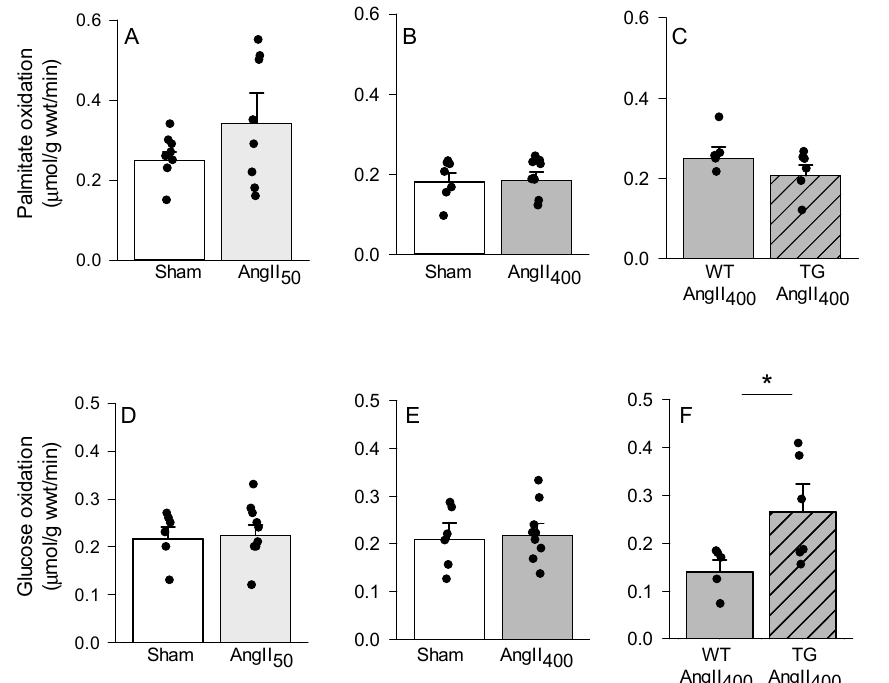
Figure 2. Palmitate ( A–C ) and glucose ( D–F ) oxidation rates assessed in isolated working hearts from C57BL/6J, wild-type (WT), and csNOX2 transgenic (TG) mice treated for two weeks with micro-osmotic pumps containing either saline (sham), 50 or 400 ng/kg/min angiotensin II (AngII 50 and AngII 400 ). The data are presented as mean ± SEM. * p < 0.05 vs. WT. The oxygen consumption rate (OCR) through the complexes in the electron transport system in the mitochondria was measured in homogenates from LV heart tissue that had been previously frozen. There was no difference in OCR in homogenates from sham and AngII-treated LV heart tissue (Figure 3 A,B). In the csNOX2 TG, AngII 400 resulted in a significant reduction in basal and residual oxygen consumption rates (ROX) compared to WT (Figure 3C). In addition, there was a non-significant tendency towards lower OCR in complex I (CI) in homogenate from csNOX2 TG AngII 400 , which might indicate altered mitochondrial respiration.